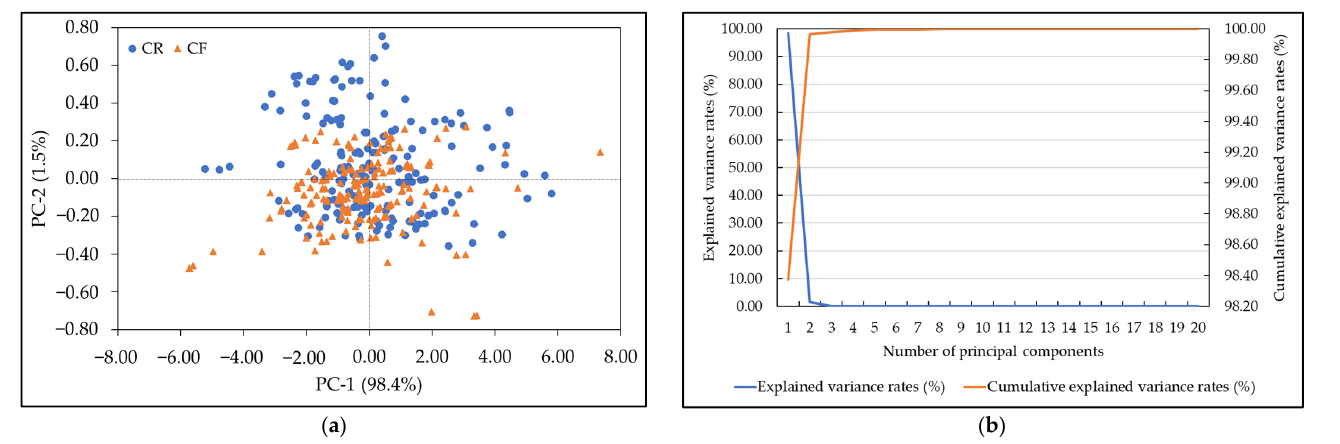
Figure 3. PCA for the chlorpyrifos-free (CF) and chlorpyrifos residue (CR) groups. ( a ) Score plot of PC1 against PC2; ( b ) explained variance rates and cumulative explained variance rates of the first 20 PCs.